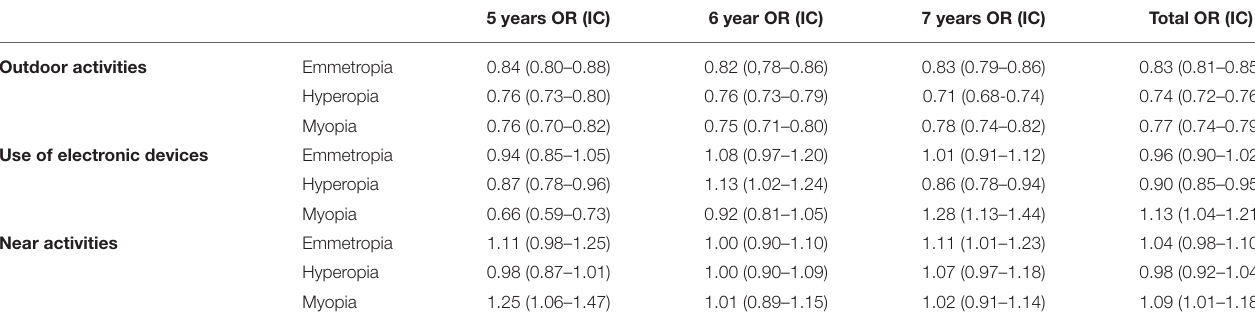
TABLE 2 | Odds ratio and confidence Interval in outdoor activities, near activities and the use of digital devices depending on age and refractive error.